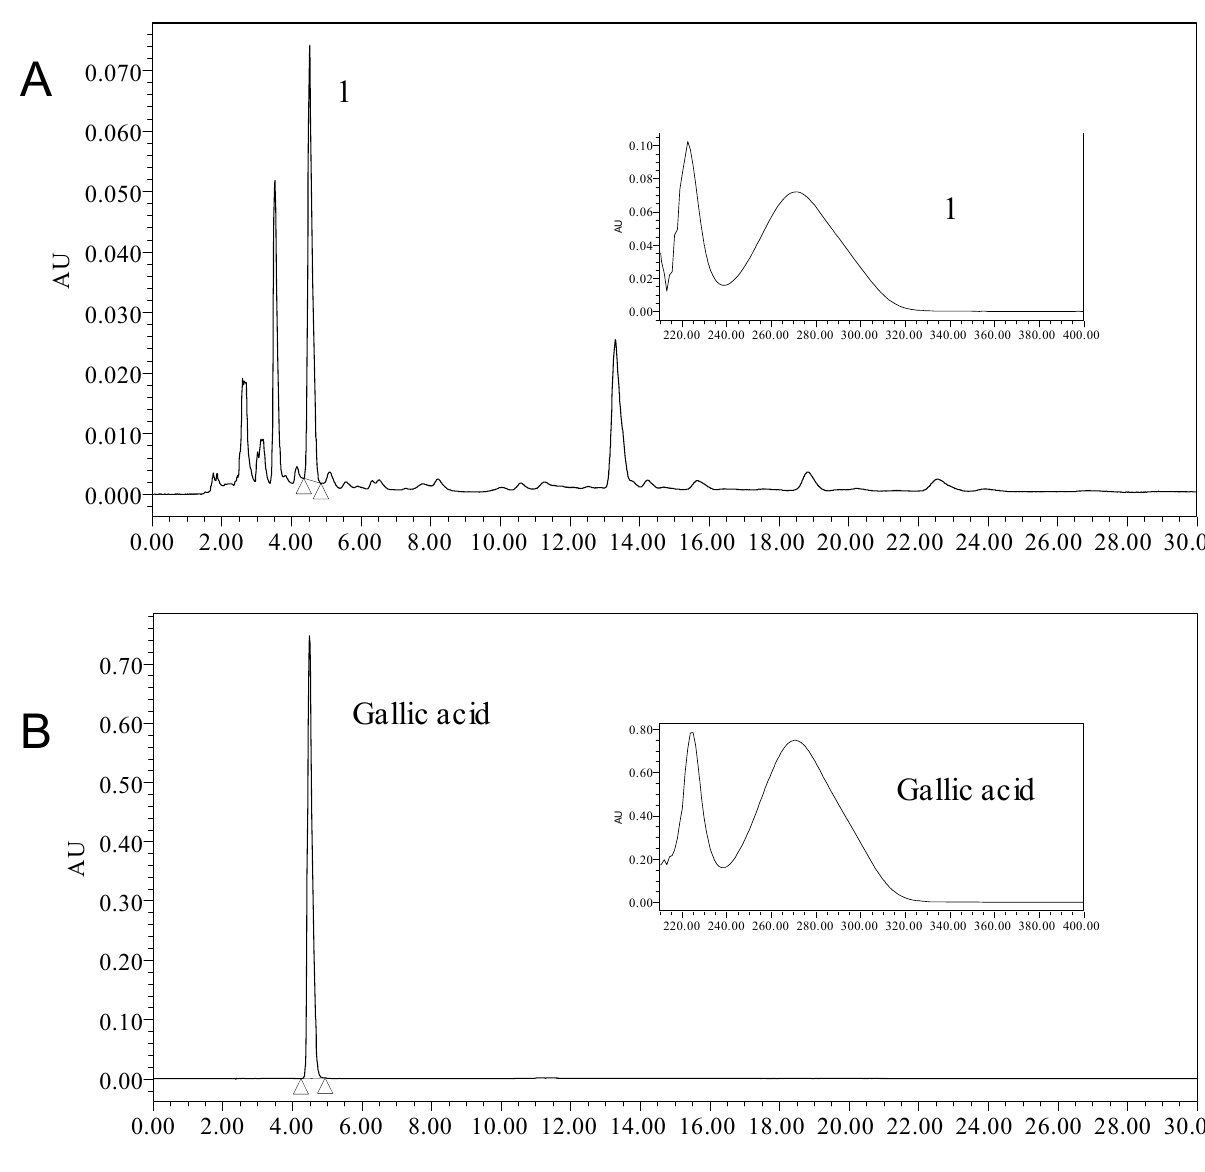
Figure 4. HPLC-UV/PDA chromatogram of the phenolic extract from seed coat of Euryale ferox Salisb.: ( A ) HPLC-UV/PDA chromatogram of the phenolic extract; ( B ) HPLC-UV/PDA chromatogram of Gallic